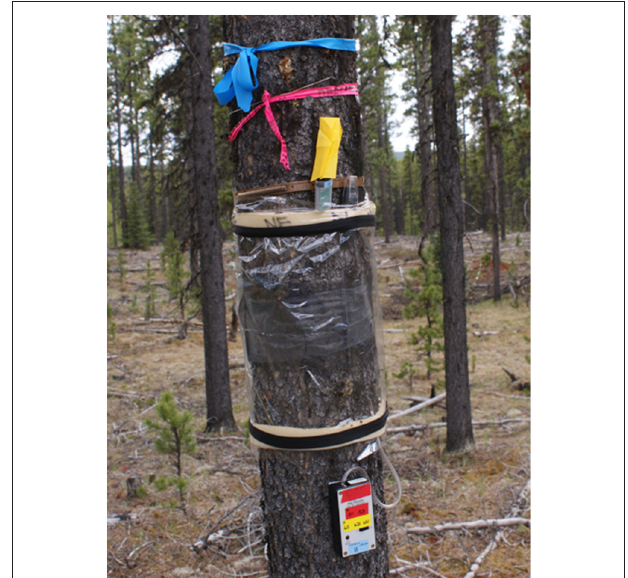
FIGURE 1 | Volatile collection of fungal inoculated lodgepole